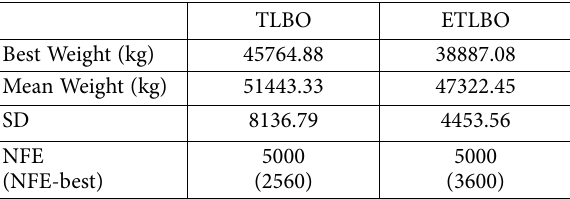
Table 9. Result of optimization algorithms in 1152-bar double layer space frame roof example